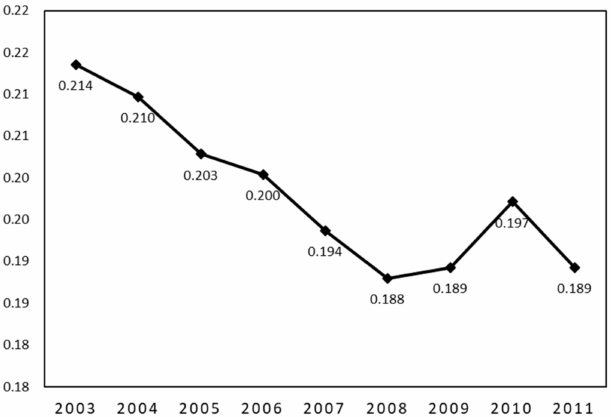
Figure 10. Annual average sea ice freeboard variations in the Arctic Ocean from 2003 to 2011.